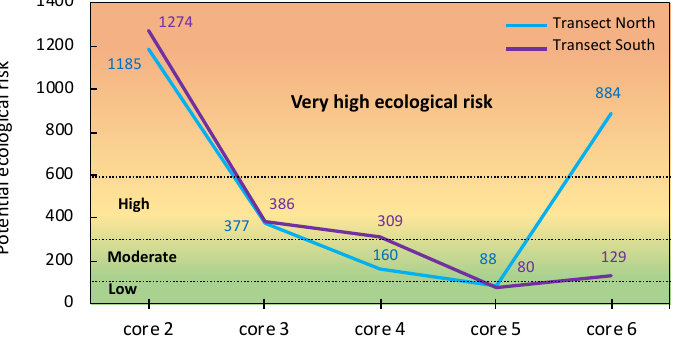
Figure 11. Potential ecological risk values of As, Cd, Cu, Pb, and Zn in the surface samples of the soil cores collected in each transect.